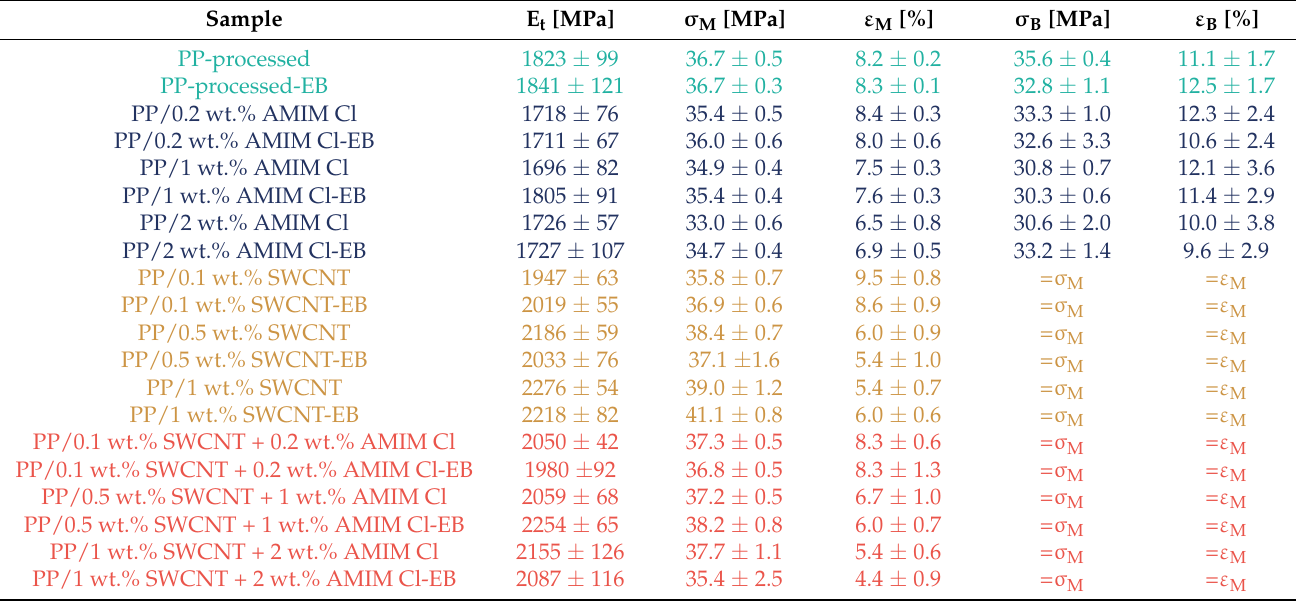
Figure 8. Typical stress–strain curves of various composites without and with IL (AMIM Cl) before and after the irradiation (EB, 18 kGy). Table 3. Mechanical properties for non-irradiated and irradiated (EB) PP, PP/IL, PP/CNT, and PP/CNT-IL composites; used IL: AMIM Cl, dose 18 kGy.